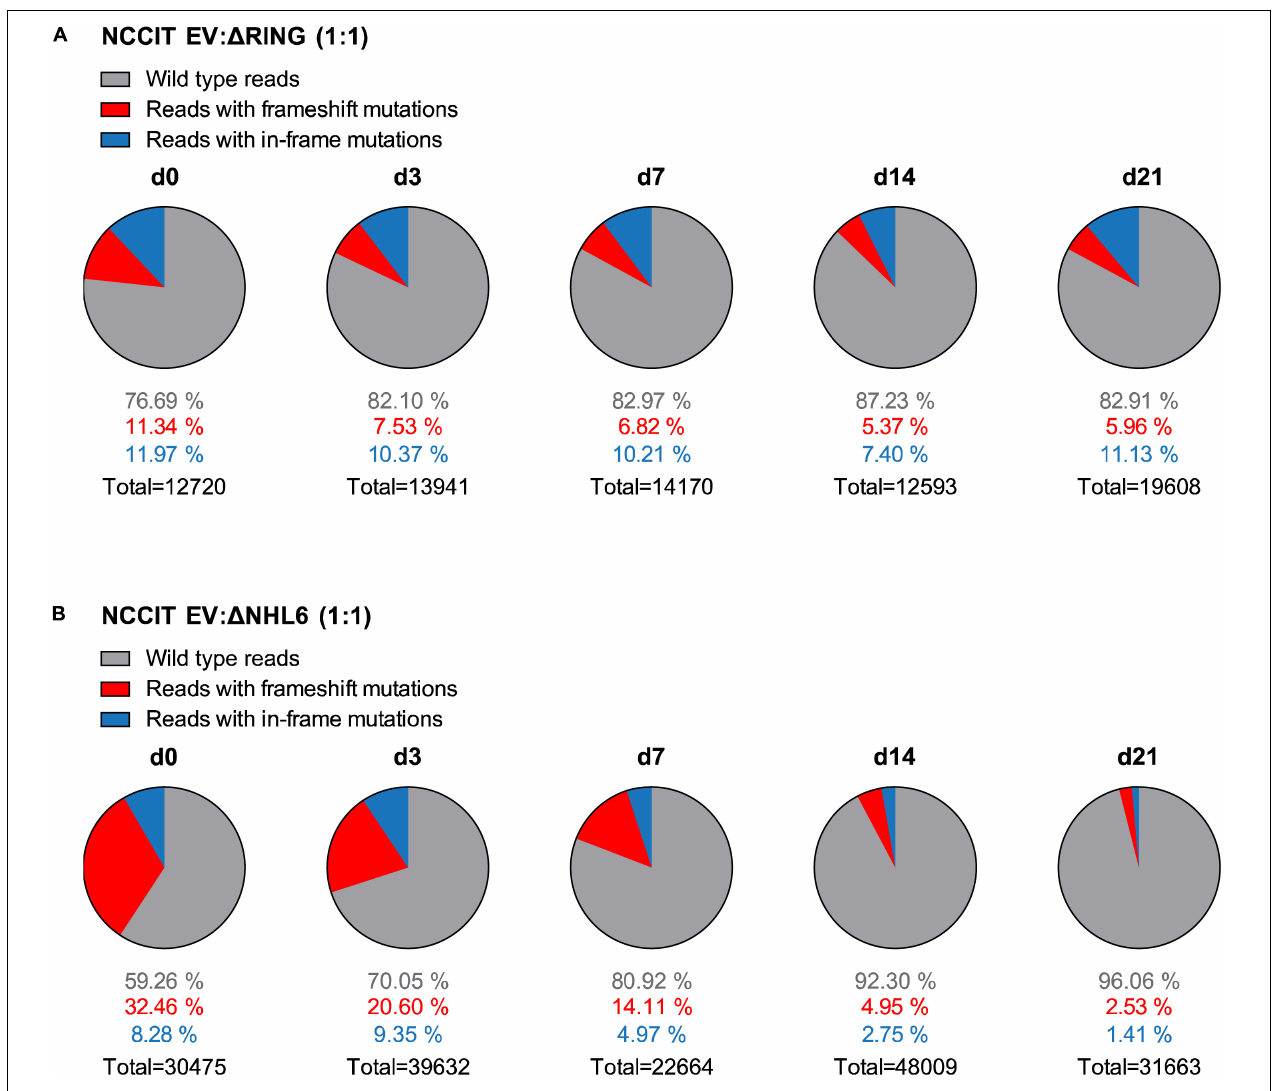
FIGURE 5 | NCCIT cells with TRIM71 mutations show population maintenance defects in growth competition assays. (A) Pie charts showing allele frequencies for wild type (EV) and TRIM71 RING mutant ( (cid:49) RING) or (B) TRIM71 NHL mutant ( (cid:49) NHL6) NCCIT cells obtained at different time points during growth competition assays. For the assay, NCCIT wild type cells (EV) were mixed 1:1 with either TRIM71 RING mutant ( (cid:49) RING) or TRIM71 NHL mutant ( (cid:49) NHL6) NCCIT cells and directly analyzed (d0) before their culturing, following by subsequent analysis at several time points (d3, d7, d14, and d21). Allele frequency was analyzed via NGS using the Illumina MiSeq platform. For TRIM71 mutant alleles, reads with in-frame mutations and frameshift mutations (loss-of-function) in each respective domain (RING or NHL) are depicted. The total number of sequencing reads for each time point is indicated under each respective pie chart. See also Supplementary Figures 8–10